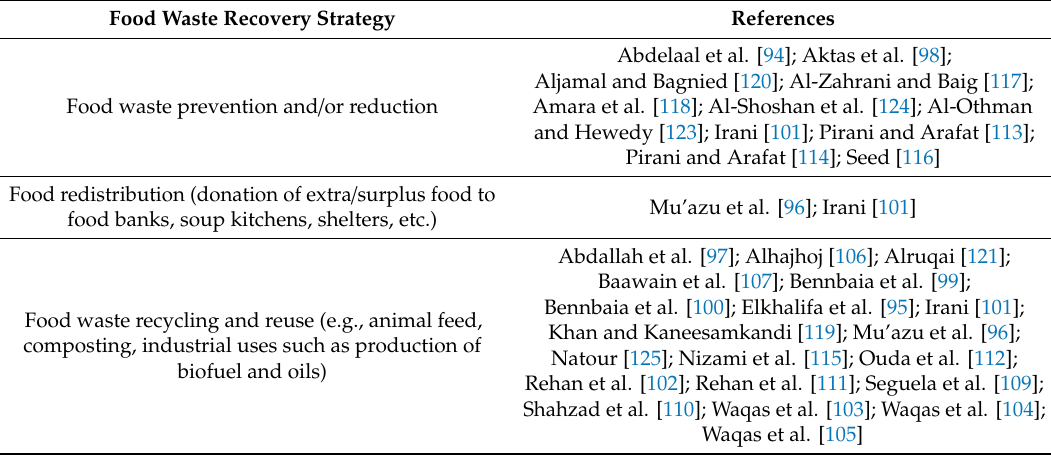
Table 5. Food waste recovery and management strategies analyzed in the literature on food waste in the